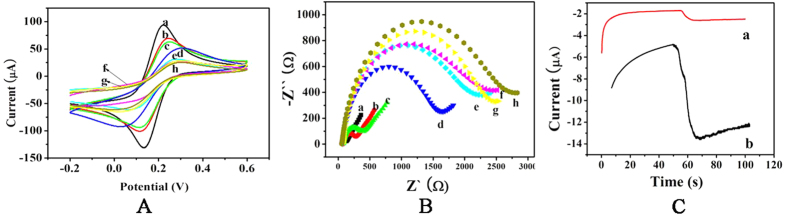
(A) CVs of the GCE (curve a), GS-SnO2-PAN/GCE (curve b), Ab1/GS-SnO2-PAN/GCE (curve c), BSA/Ab1/GS-SnO2-PAN/GCE (curve d), HIgG/BSA/Ab1/GS-SnO2-PAN/GCE (curve e), B-Ab2/HIgG/BSA/Ab1/GS-SnO2-PAN /GCE (curve f), SA/B-Ab2/HIgG/BSA/Ab1/GS-SnO2-PAN /GCE (curve g), Fe3O4@APTES-B/SA/B-Ab2/HIgG/BSA/Ab1/GS-SnO2-PAN/GCE (curve h); (B) Nyquist diagrams of electrochemical impedance spectra recorded from 0.1 to 105 Hz of bare GCE (curve a), GS-SnO2-PAN/GCE (curve b), Ab1/GS-SnO2-PAN/GCE (curve c), BSA/Ab1/GS-SnO2-PAN/GCE (curve d), HIgG/BSA/Ab1/GS-SnO2-PAN/GCE (curve e), B-Ab2/HIgG/BSA/Ab1/GS-SnO2-PAN/GCE (curve f), SA/B-Ab2/HIgG/BSA/Ab1/GS-SnO2-PAN/GCE (curve g), Fe3O4@APTES-B/SA/B-Ab2/HIgG/BSA/Ab1/GS-SnO2-PAN/GCE (curve h) modified electrode in PBS containing 2.5 mM K3Fe(CN)6; (C) Comparison between multiple amplification amperometric responses of (a) one-off modified and (b) multiple replication modified electrodes.